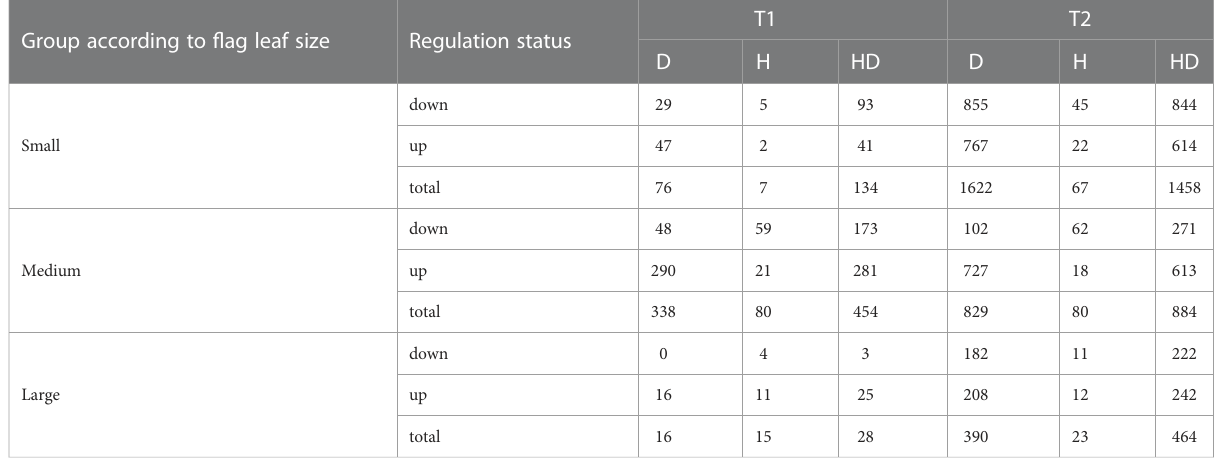
TABLE 2 Number of down- and upregulated genes in genotypes classi fi ed to different groups according to fl ag leaf size, at time points T1 and T2, in comparisons between drought (D), heat (H), their combination (HD) v. control.